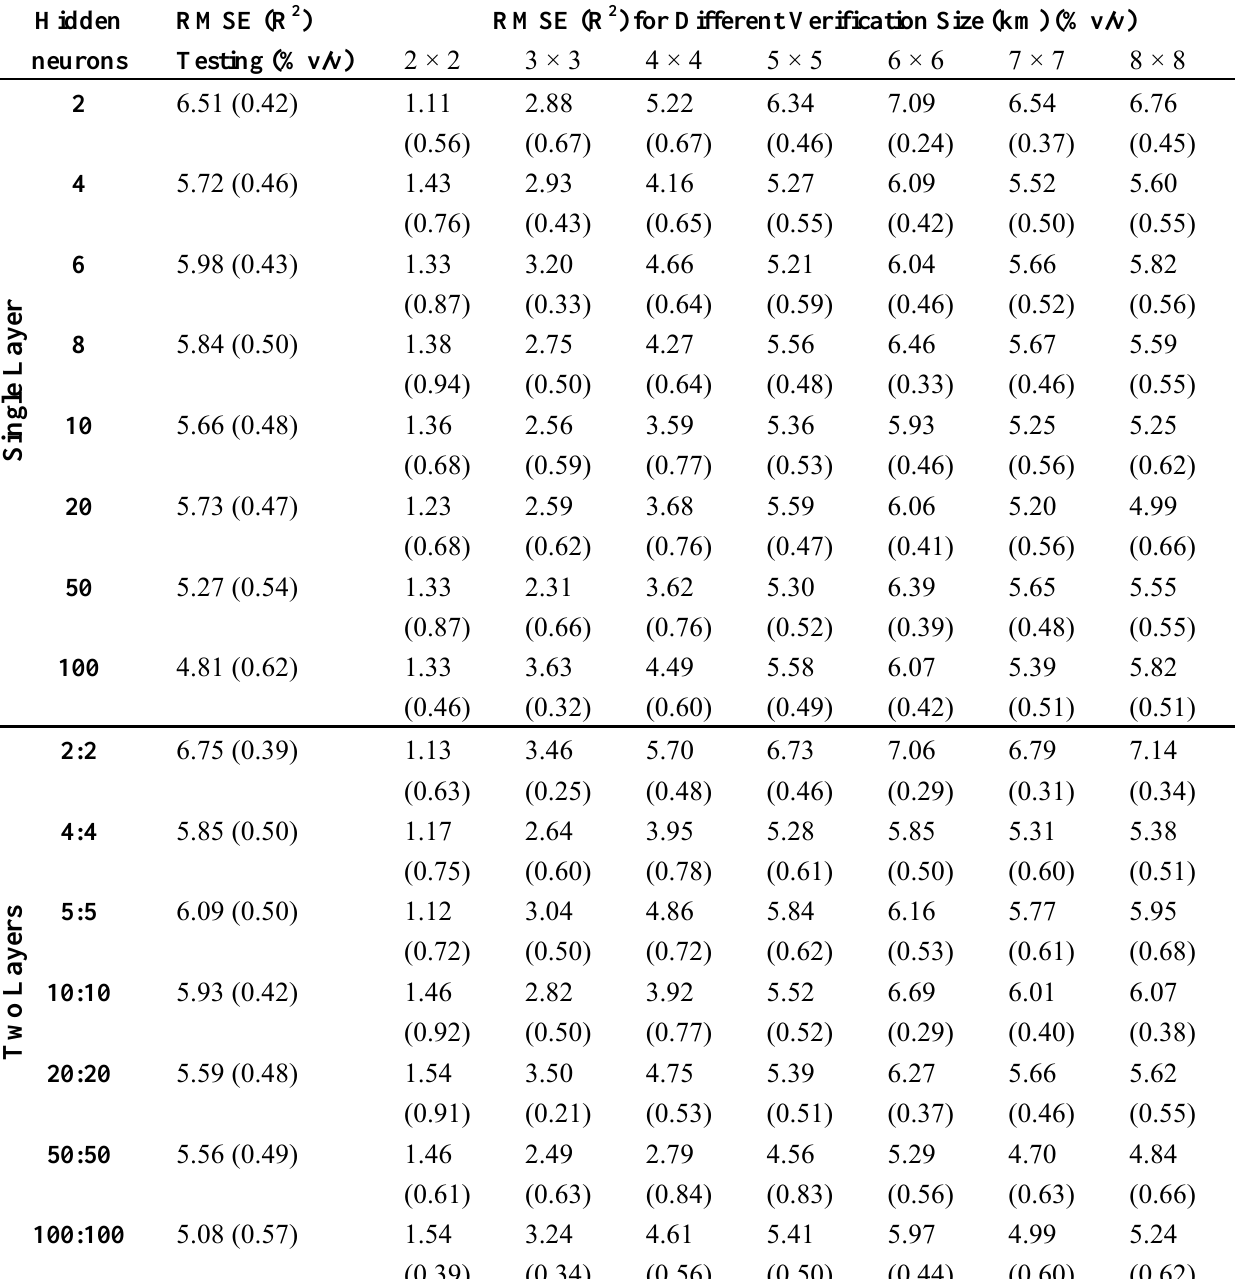
Table 5. As for Table 3 but using TbH, TbV and LST as